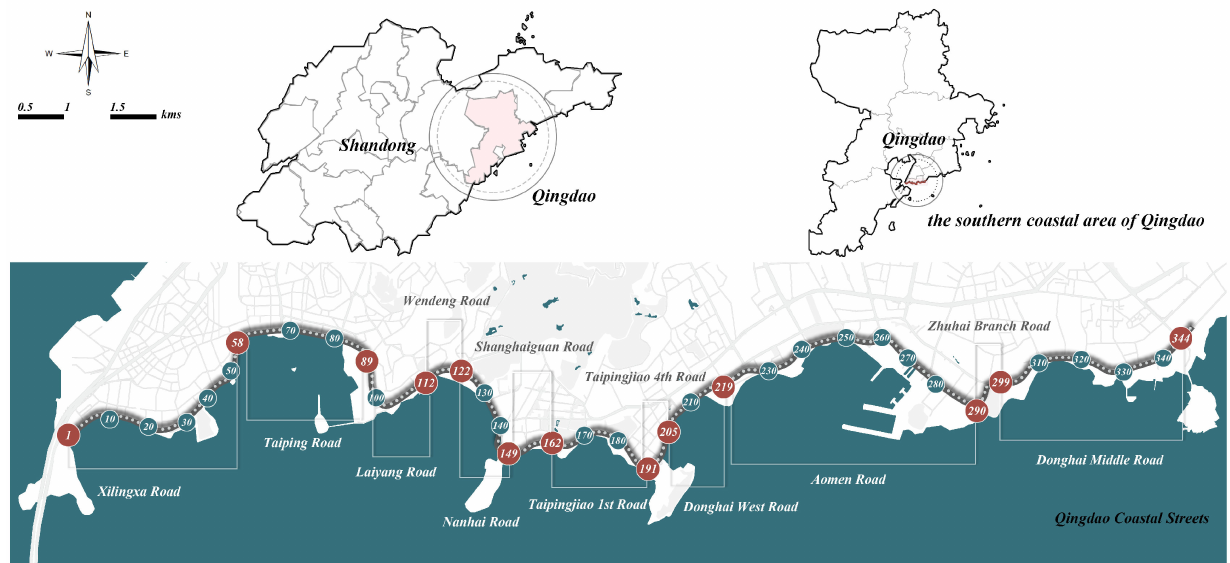
Figure 1. Study site and distribution of sample